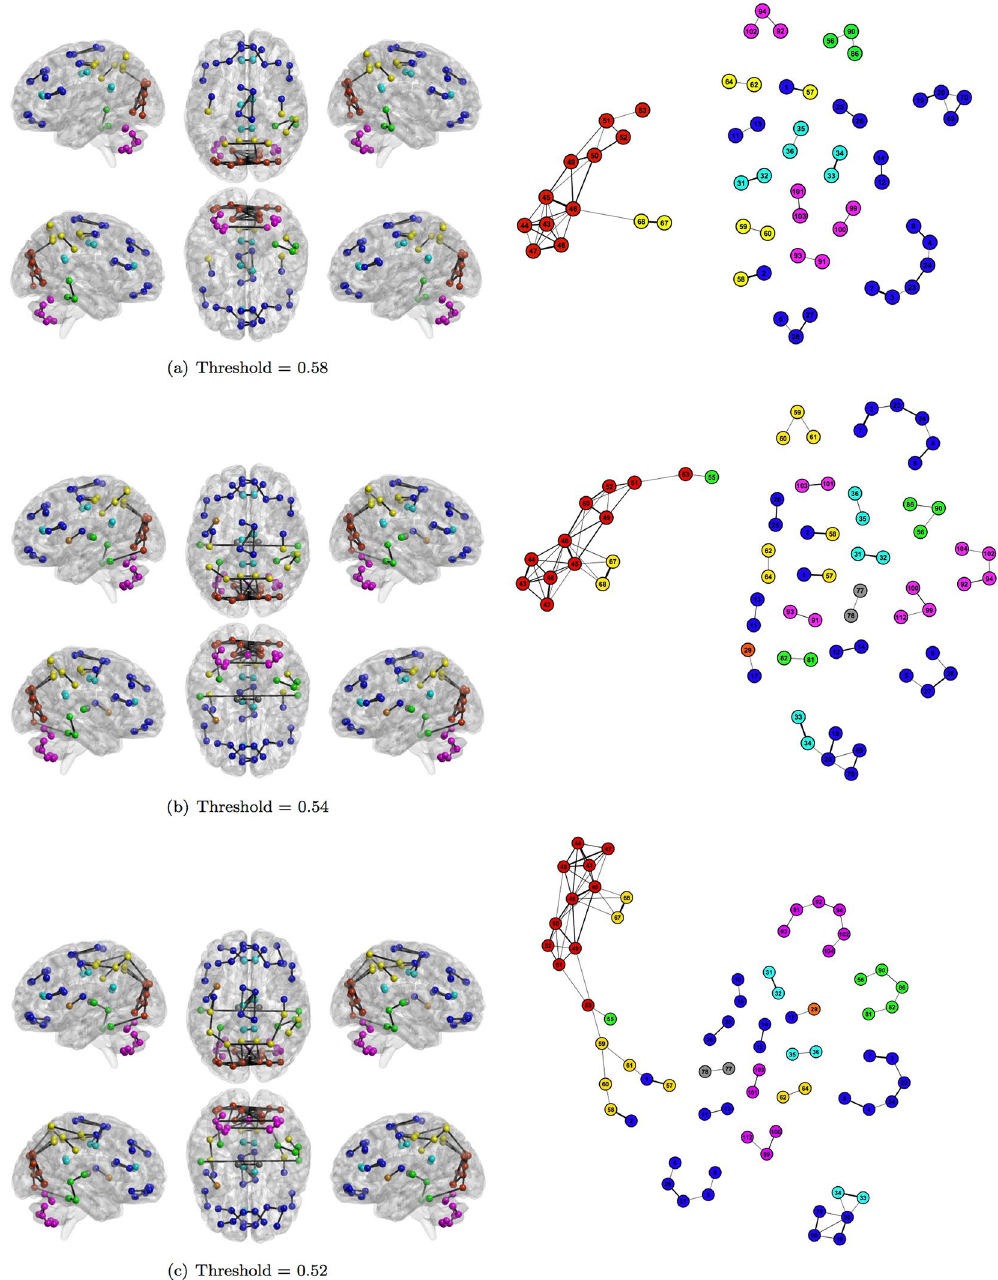
Figure 6. Snapshots of the human functional brain network. Each snapshot is realized thresholding the correlation matrix. Thresholds are chosen looking at the most significant deviations of plateaux length of the real percolation curve from its ensemble of randomizations (Fig. 2(b)). Colors represent anatomical regions according to the grouping of AAL parcellation in Fig. 3(a): Frontal Lobe; Insula; Cingulate; Temporal Lobe; Occipital Lobe; Parietal Lobe; Deep Grey Matter; Cerebellum. Link thickness represents the strength of